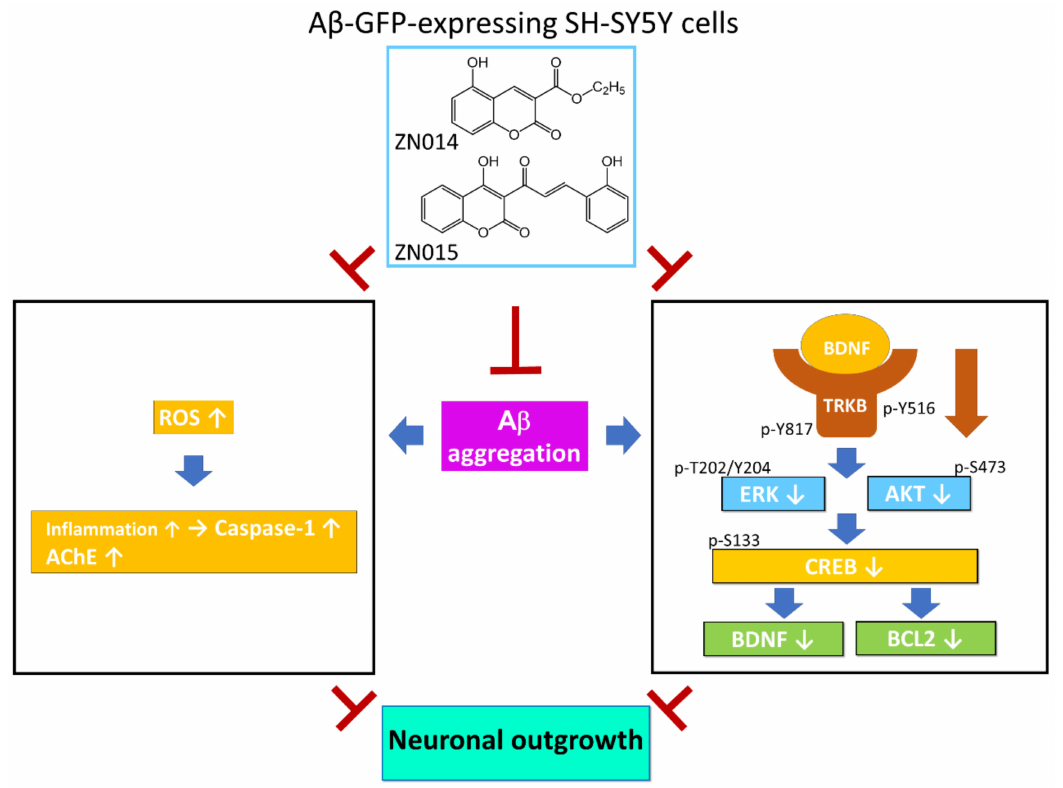
Figure 6. Model for A β aggregation reduction and neuronal outgrowth promotion by synthetic coumarin derivatives ZN014 and ZN015 in an A β -GFP–expressing SH-SY5Y AD cell model. ZN014 and ZN015 inhibit ROS to reduce caspase-1 and AChE activities in SH-SY5Y cells, both of which would otherwise worsen A β -induced pathology. In addition, ZN014 and ZN015 activate TRKB-CREB signaling in SH-SY5Y cells to promote neuronal